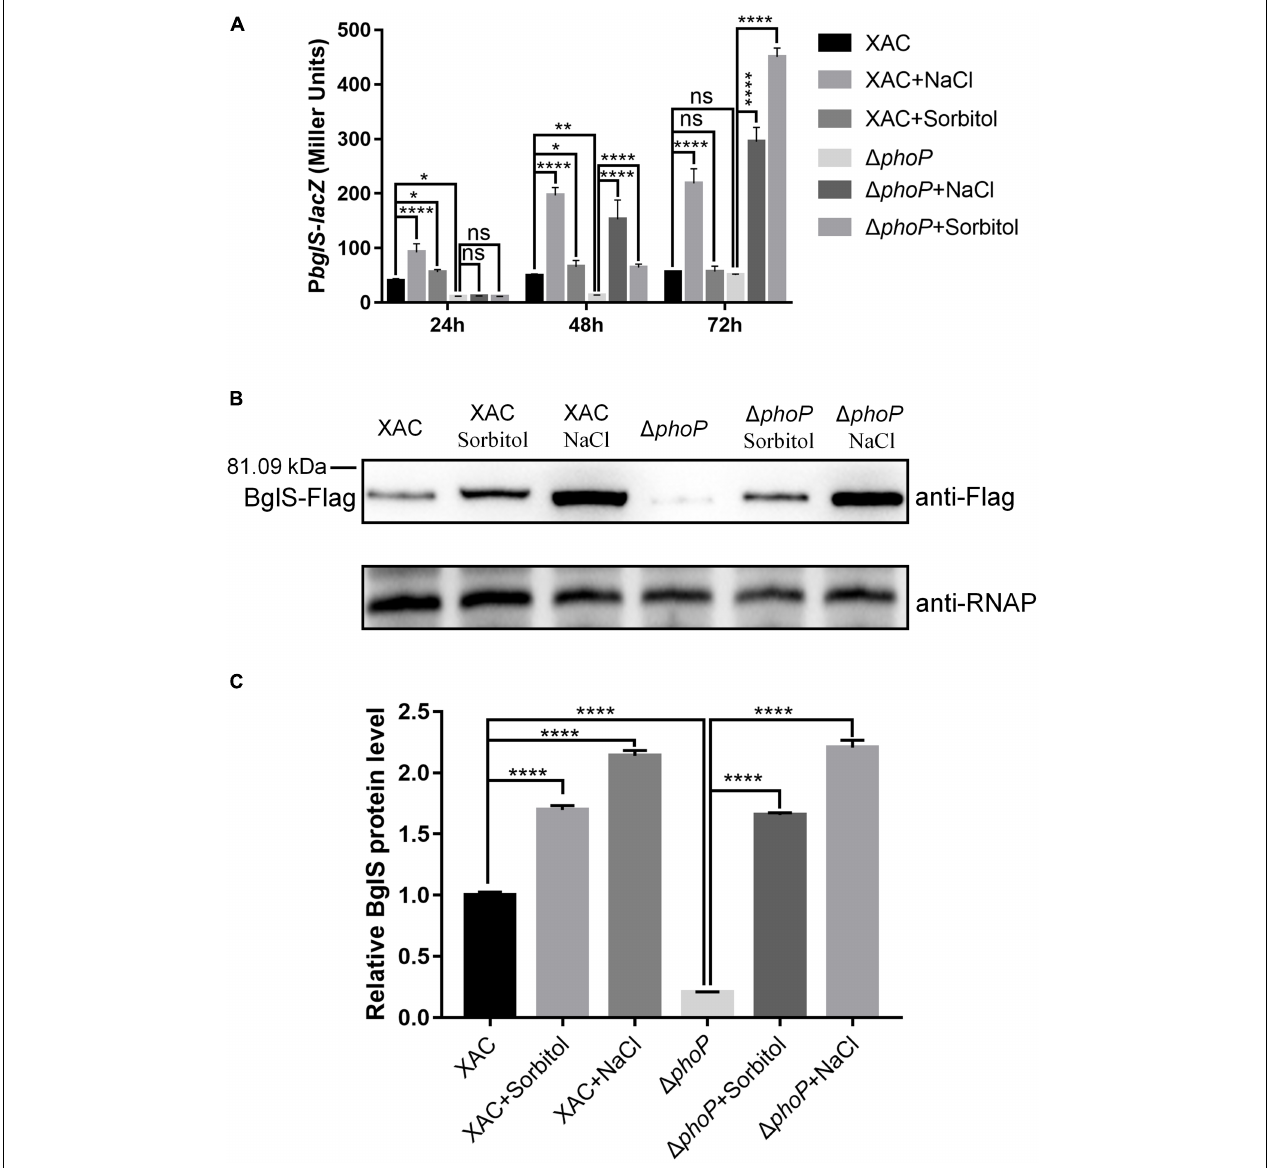
FIGURE 7 | Low osmostress induced BglS expression in X. citri . (A) The effect of low osmostress on bglS gene expression was measured by assessing the β -galactosidase activity of the P bglS -lacZ transcriptional fusions in the X. citri and (cid:49) phoP strains. (B) Expression of BglS-Flag in the X. citri and (cid:49) phoP strains in NYG or NYG supplemented with 0.05 M NaCl or Sorbitol to an OD 600 of 1.0. The Western blot was performed by using anti-Flag antibodies. The α subunit of RNA polymerase was used as an internal loading control and detected through a specific antibody (anti-RNAP). (C) Quantification and statistical analysis of BglS protein levels based on three biological replicates of the experiment mentioned in section (B) . Error bars, means ± standard deviations ( n = 3). * P < 0.05, ** P < 0.01, **** P < 0.0001, assessed by one-way ANOVA. All experiments were repeated three times with similar